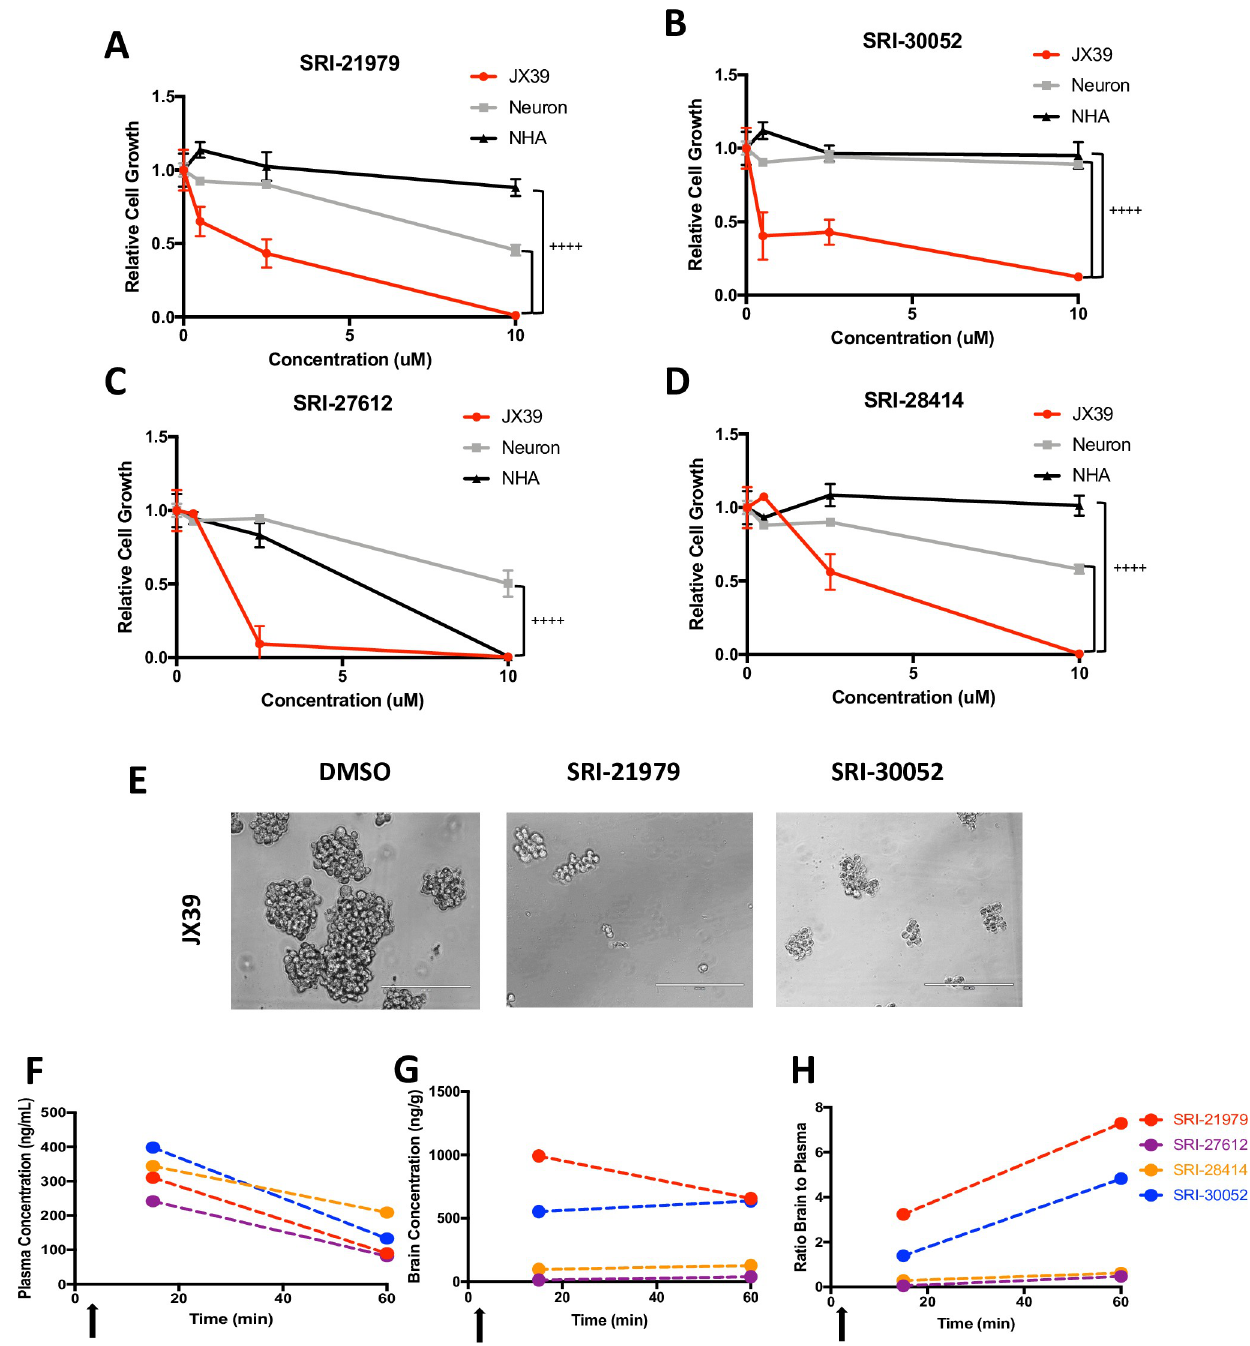
Fig 2. DRD3 antagonists have greater growth inhibitory potential against GBM cells than normal human astrocytes or neurons and cross the blood brain barrier. Cells isolated from JX39 (red) GBM PDXs, normal human astrocytes (NHA, black), and induced pluripotent stem cell derived neurons (grey) were treated with vehicle control or the indicated concentrations of (A) SRI-21979, (B) SRI-30052, (C) SRI-27612, or (D) SRI-28414. Growth in cell titer assays was determined seven days after treatment. Representative images of cells treated with SRI-21979 and SRI-30052 are shown (E) . Scale bar represents 200um. ++++p < 0.0001 with ANOVA comparison of effects of 10 mM of the indicated drug in JX39 cells in comparison to NHAs and/or neurons. Levels of the indicated DRD3 antagonist detected via LC-MS in the (F) plasma or (G) brain at 15 or 60 minutes post intraperitoneal injection of 5 mg/kg drug with no detection in vehicle controls. (H) Brain to Plasma ratios for each DRD3 antagonist are shown. SRI-21979 (red) and SRI-30052 (blue) were found to accumulate in the brain relative to plasma but SRI-27612 (purple) and SRI-28414 (orange) were also detected in the brain. Time of injection is indicated with